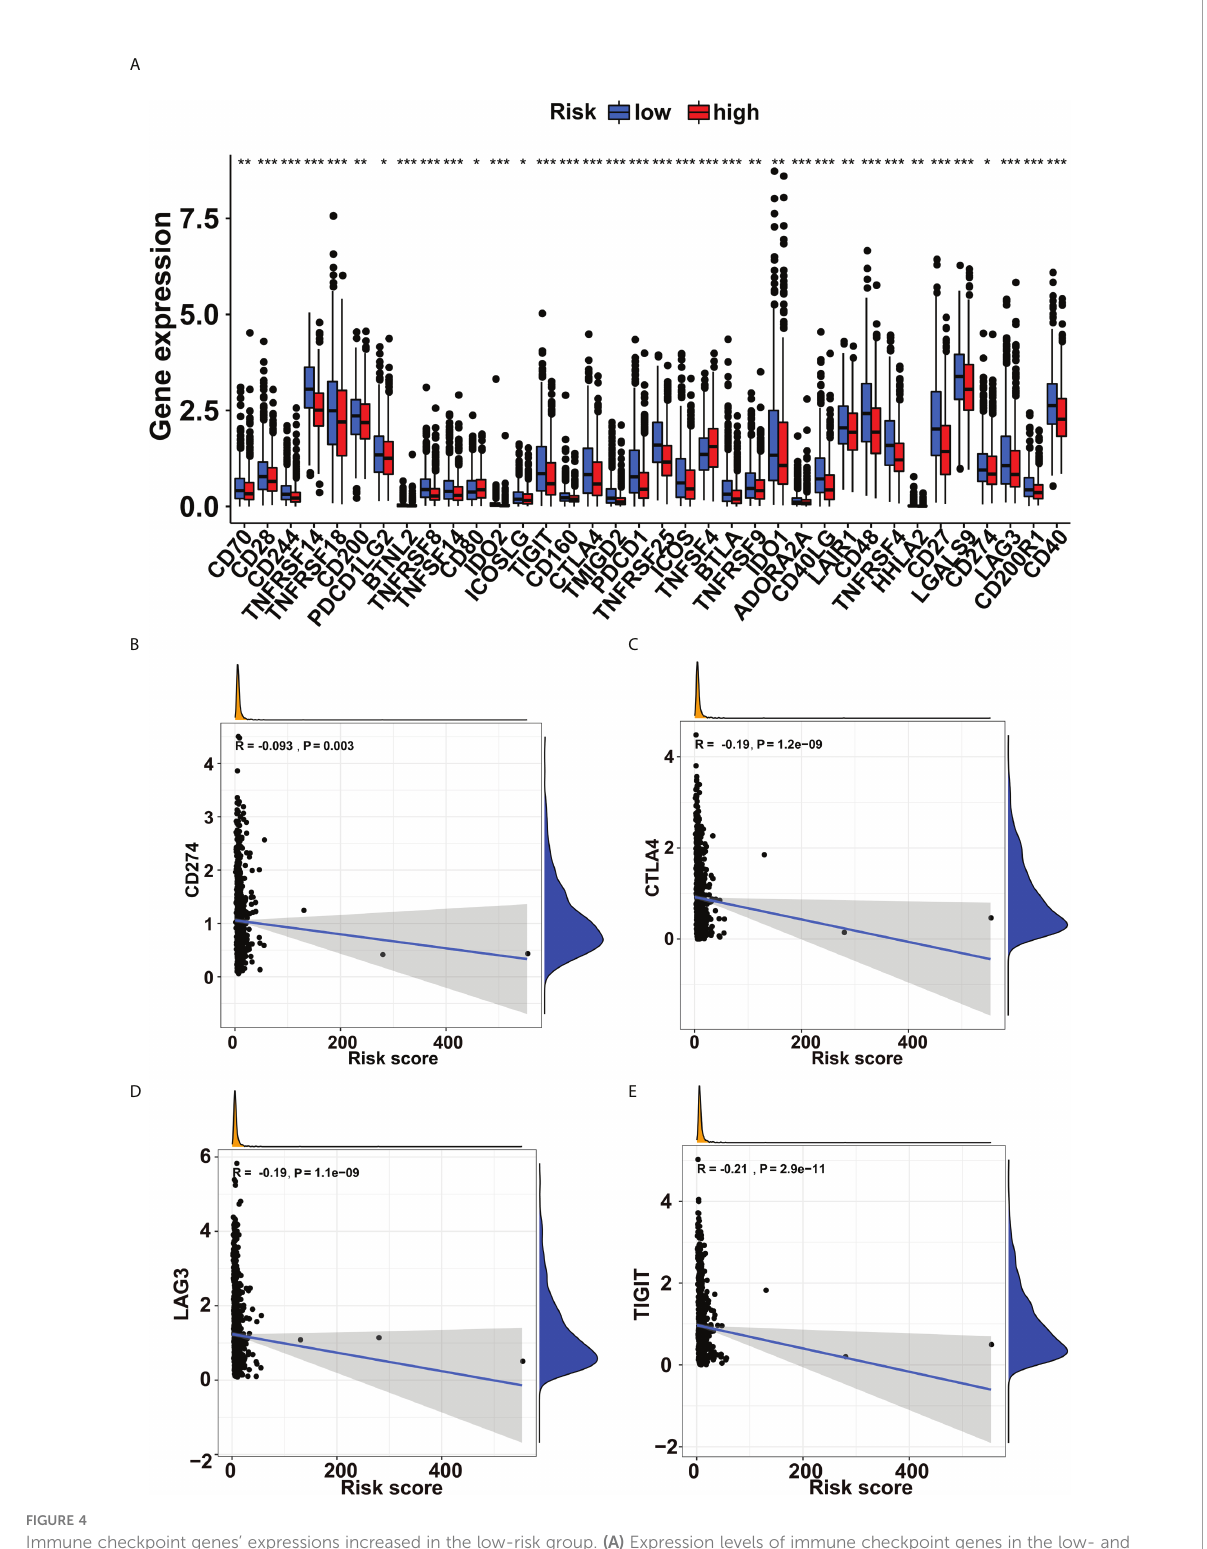
FIGURE 4 Immune checkpoint genes ’ expressions increased in the low-risk group. (A) Expression levels of immune checkpoint genes in the low- and high-risk groups. The expressions of (B) CD274, (C) CTLA4, (D) LAG3, and (E) TIGIT were negatively correlated with risk scores in breast cancer. *p<0.05, **p<0.01,